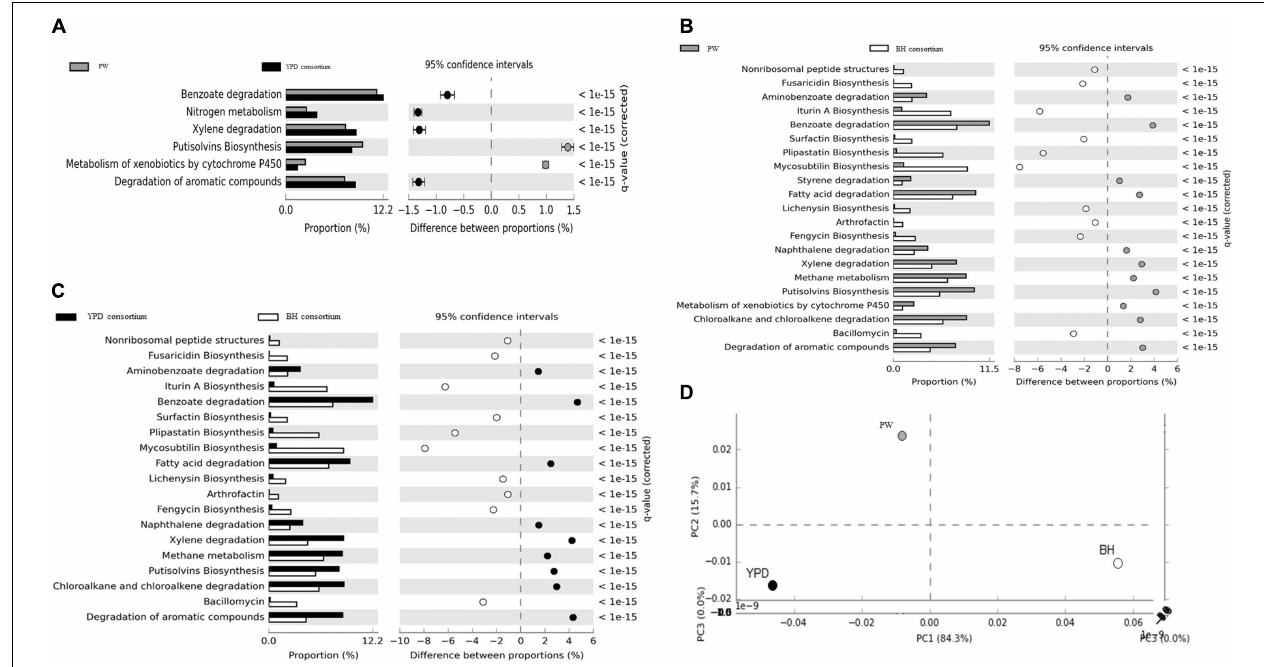
FIGURE 4 | Functional annotation of shotgun metagenome sequencing performed using the BioSurfDB database. (A) Statistical differences in metabolic pathways between YPD consortia and PW. (B) Statistical differences in metabolic pathways between the consortia BH and PW. (C) Functional comparison between the consortia BH and YPD. (D) Principal component analysis between BH and YPD consortia and PW. The graph shows the statistical differences between functional profiles observed in the metagenomes. q < 0.05 was considered statistically significant, using the two-sided Fisher’s exact test.